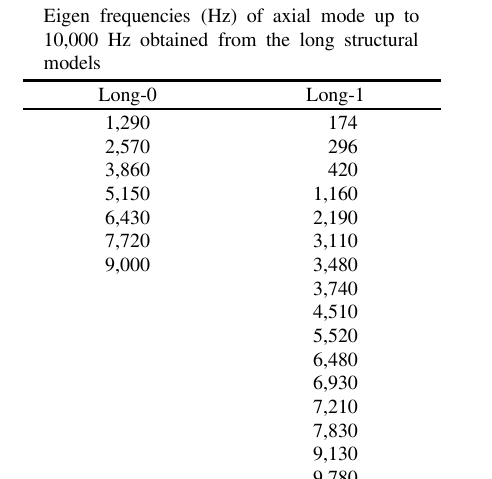
Table 8 Eigen frequencies (Hz) of axial mode up